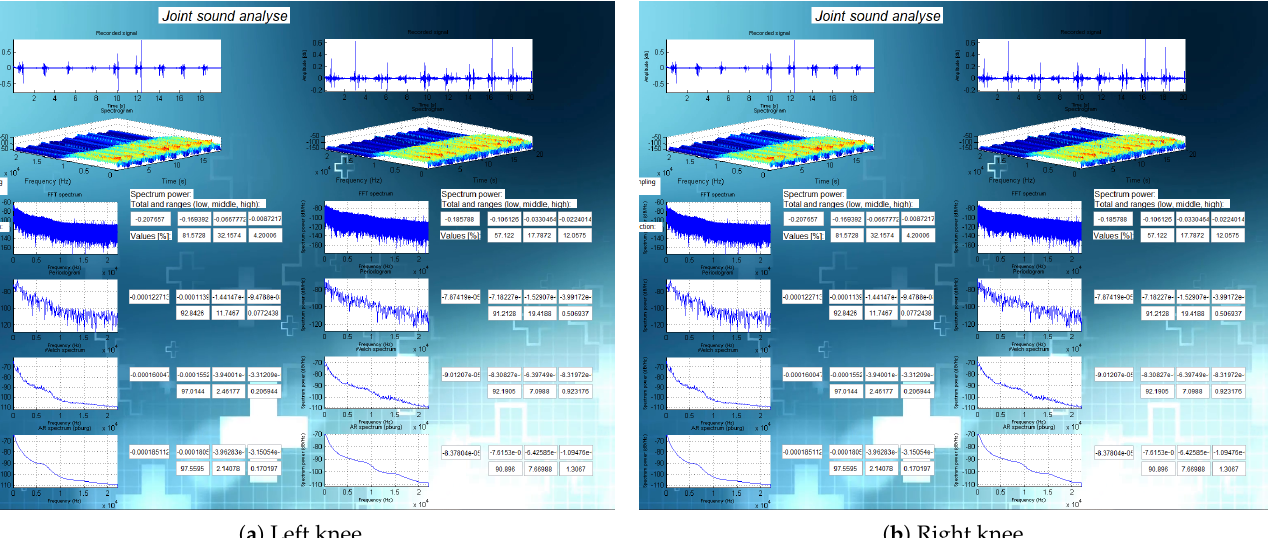
Figure A5. Analysis for subject 5. 6. gender: Male, age: 37, height: 189 cm, body mass: 88 kg, lifestyle: Sedentary-standing, physical condition: Average, knee injuries: Rupture of cruciform ligaments in the right knee, other remarks: Cycling, gym (Figure